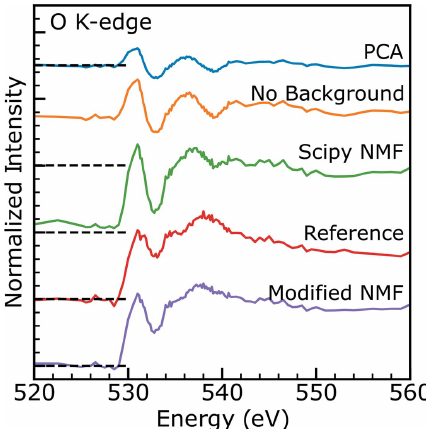
Figure 2 Comparison of the interfacial spectral component for different data analysis methods. PCA (blue) is shown for comparison. NMF without background subtraction (orange), NMF implemented in SciPy by removing negative data points (green) and the new modified NMF (purple) methods are compared with the region closest to the defect in Fig. 1 (red). Dashed lines represent the zero point for each spectrum (note the offset between the orange trace and its dashed line as the background is not subtracted). The modified NMF trace most closely resembles the actual spectrum of the region closest to the defect.